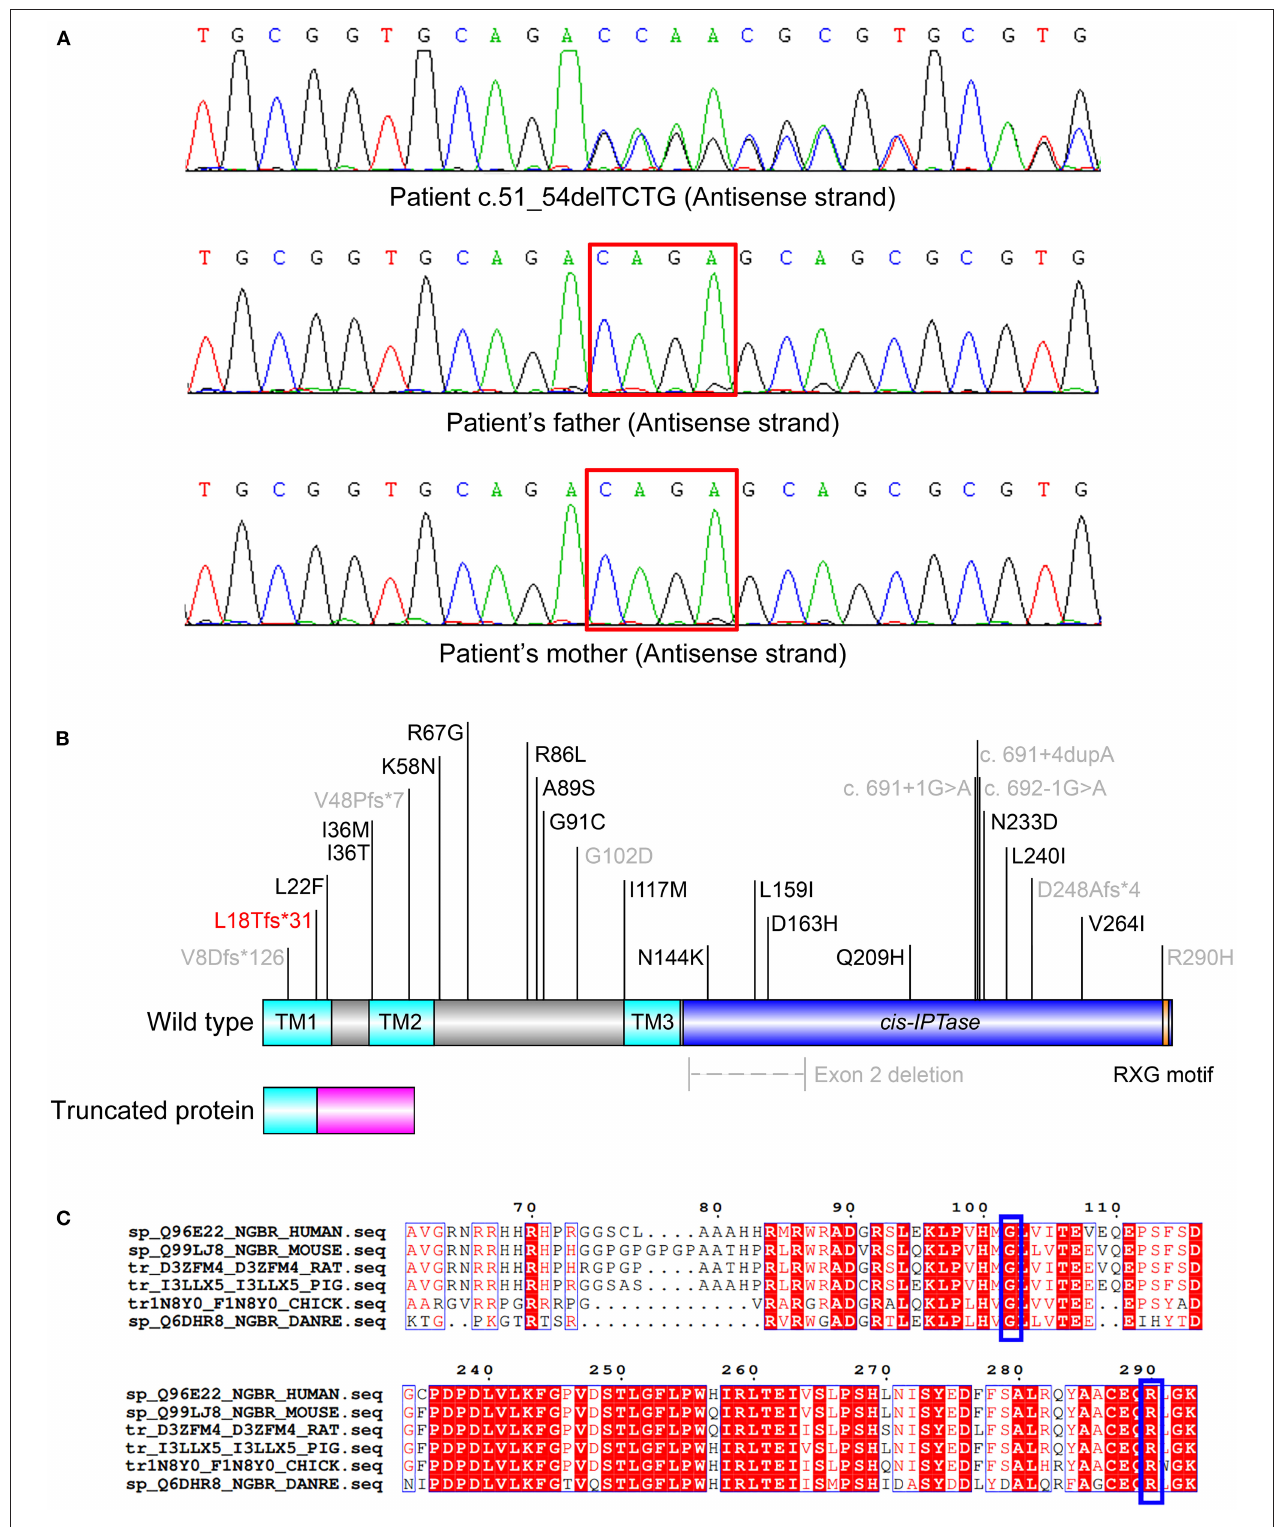
FIGURE 1 | (A) De novo heterozygous variants of c.51_54delTCTG in the patient. (B) Scheme of the reported disease-causing mutations of NUS1 . The transmembrane (TM) 1 (AA 1-23), TM2 (AA 35-56) and TM3 (AA 117-135) domains are colored in cyan. The cis-IPTase domain (AA 136-293) is colored in blue. The RXG motif (AA 290-292), which is crucial for the prenyltransferase activity, is colored in orange. The 31 miscoded amino acids of the truncated protein are colored in magenta. The pathogenic variant reported in this study is colored in red and those reported with detailed clinical features are colored in gray. (C) Alignment of the NUS1 proteins of various species. Residues G102 and R290 (indicated in blue boxes) are highly conserved.